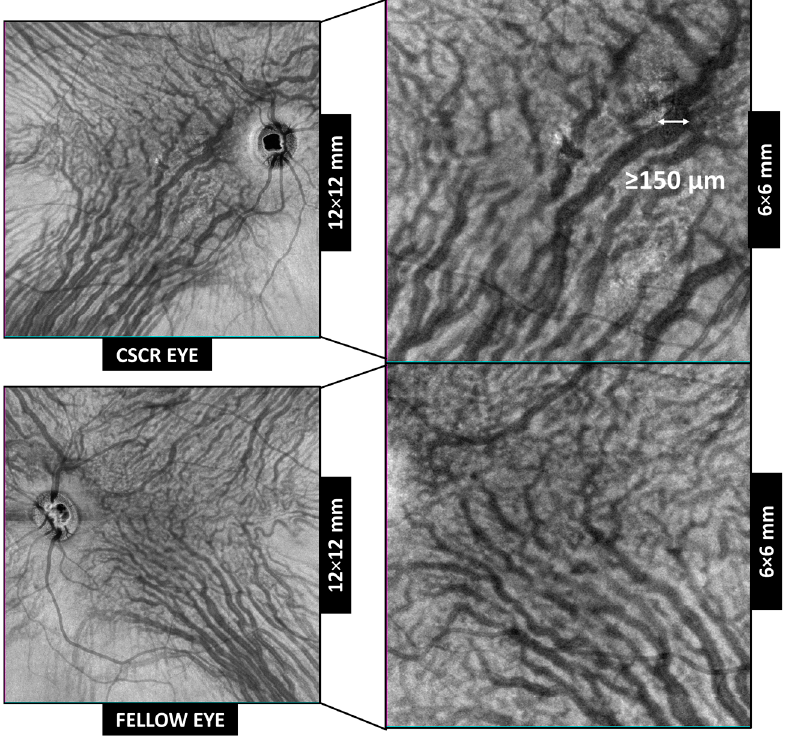
Figure 1. En face optical coherence tomography of the macular region used to analyze the presence of intervortex veins anastomosis in a cube scan of 6 × 6 mm and 12 × 12 mm in central serous chorioretinopathy (CSCR) eyes (upper row) and fellow unaffected eyes (bottom row).